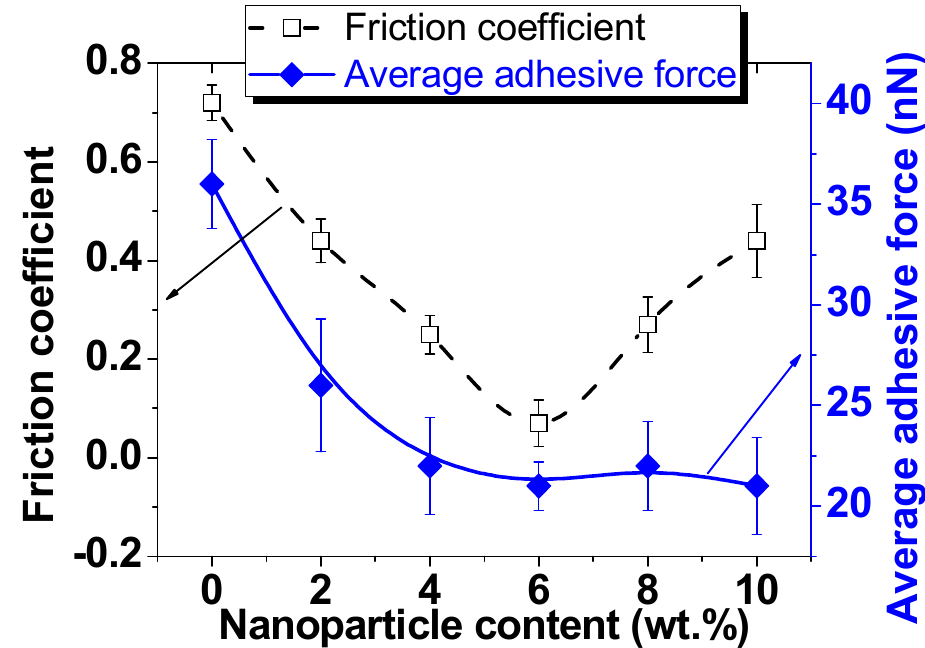
Figure 10. The friction coefficient and average adhesive force of “MZFA/PVA” nanocomposites. It was found that despite the low surface energy, the pure matrix has the highest adhesion force to the probe (36 nN). It should be noted that this refers to the adhesion